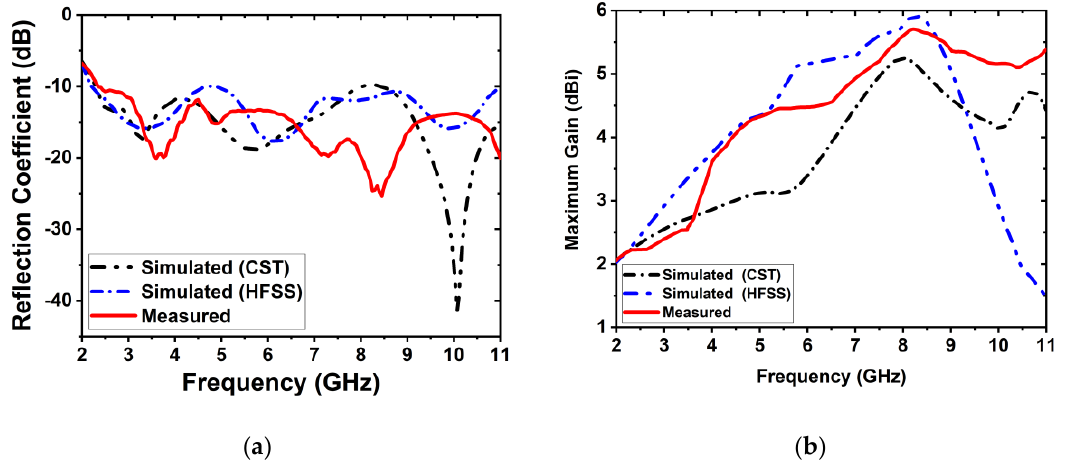
Figure 8. The measured and simulated: ( a ) Reflection coefficient (S 11 ) and ( b ) Maximum gain of the prototype.